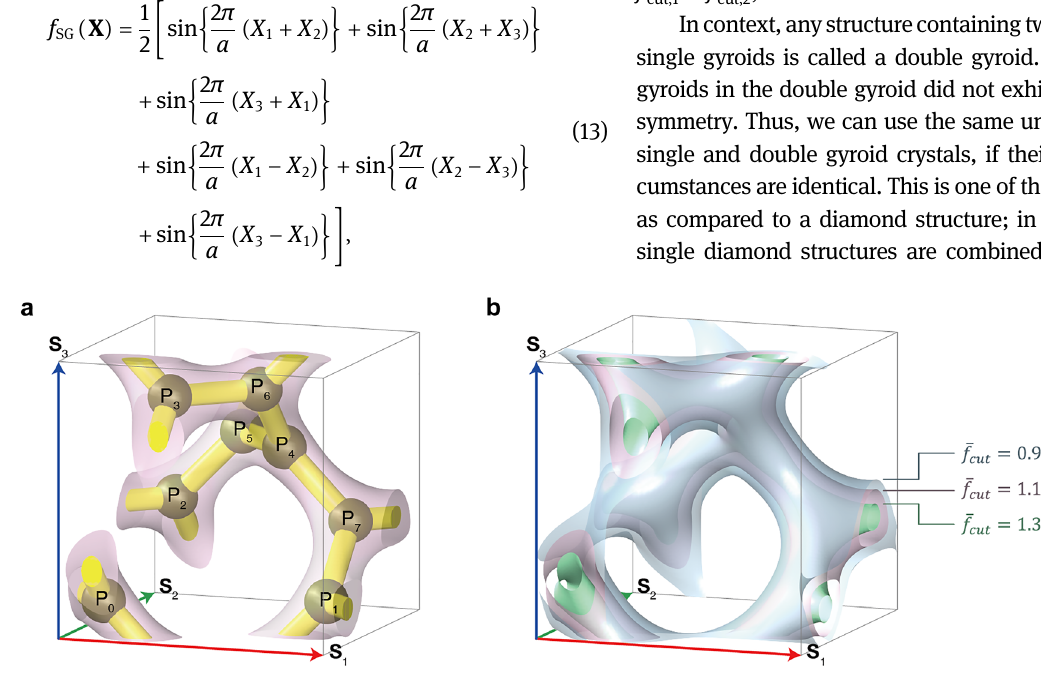
Figure 2: Level-set surface of single gyroid. (a) Level-set surface enclosing ball-stick single gyroid; f cut = 1 . 15. (b) Single gyroid level-set surfaces with various values of f cut .